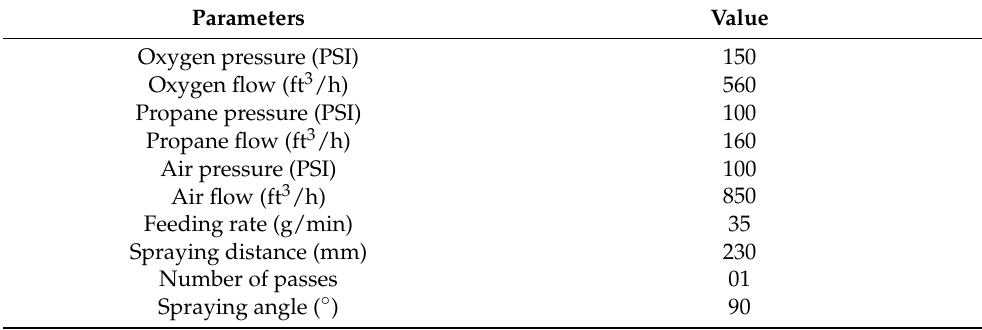
Figure 1. Specimen configuration for the 3-point bending fatigue test. ( a ) schematic of the specimen and the position of the coating in the fatigue test apparatus, ( b ) the specimen and its positioning in the fatigue equipment. Table 1. HVOF spraying parameters of the Cr 3 C 2 -25NiCr